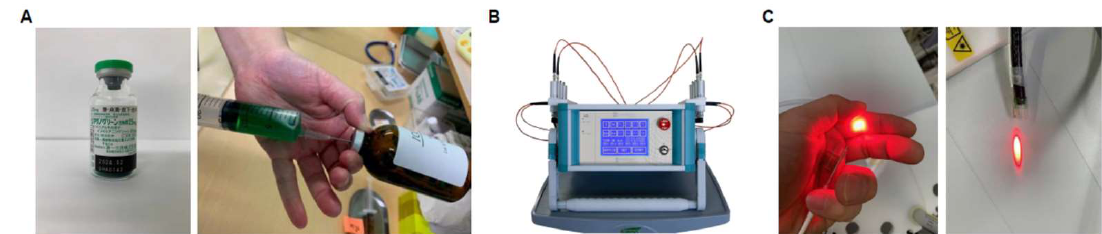
Figure 1. ( A ) Indocyanine green (ICG) ( left ). Five mg of ICG was dissolved in water and mixed with an 8.85-mM liposome solution as ICG liposomes ( right ). ( B ) Image of multi-laser delivery system (MLDS). ( C ) MLDS optical fiber shining a 635-nm laser ( left ). The device was modified and installed so that the laser could be applied directly to the target region endoscopically ( right ).